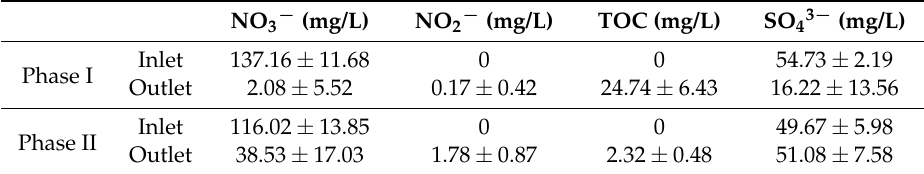
Table 1. Summary of biofilter performance in Phase I and Phase